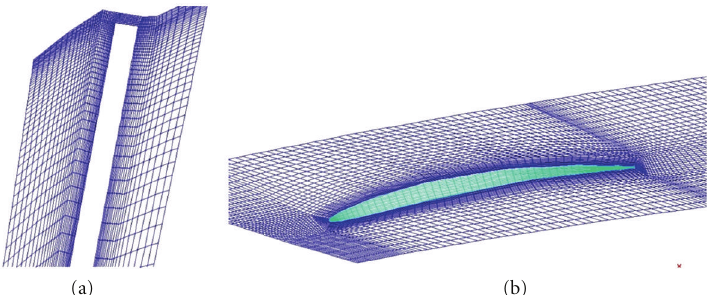
Figure 10: View of a structured grid at (a) horizontal plane crossing the blade tip and (b) cross-section plane located at the blade centre.